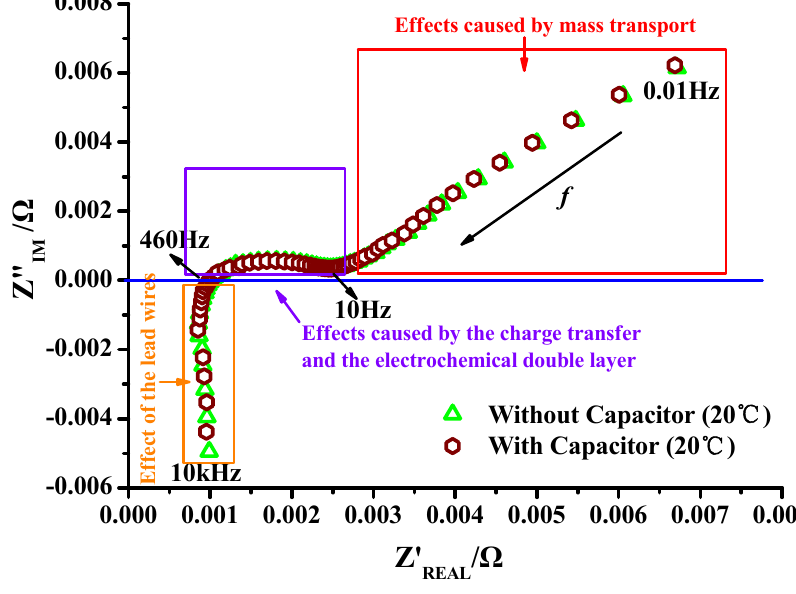
Figure 17. Correspondences between EIS curve and internal polarization